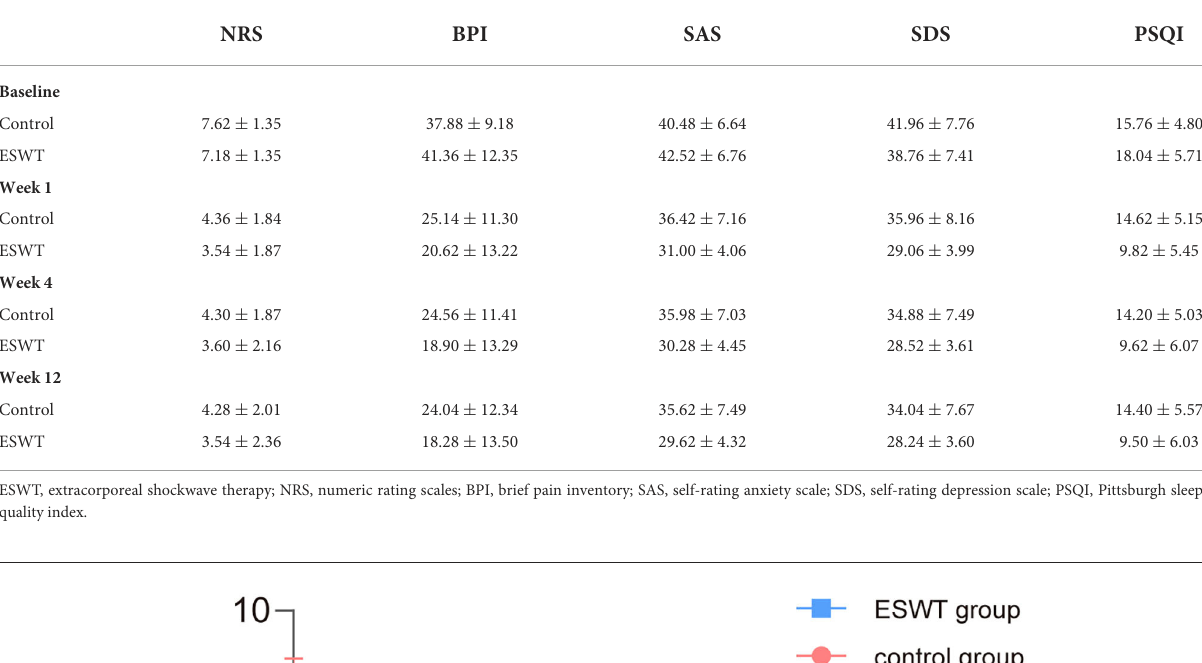
TABLE 3 Baseline and post-treatment outcome scores.